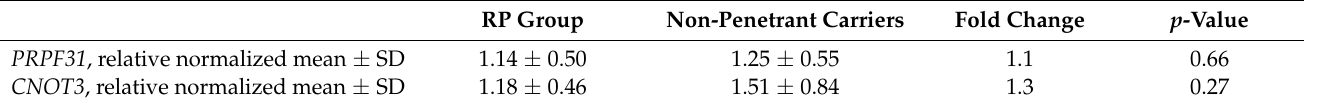
Figure 2. Numbers of analyzed samples and the individuals’ RP status in each step of the study. Table 1. Relative mean expression values, normalized to GAPDH , and unpaired two-tailed t -test significance between the groups.